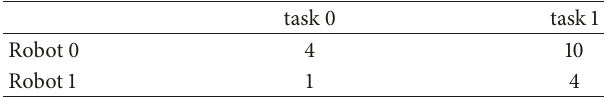
Table 1: Example in which maximizing sum of efficiency does not minimize makespan.